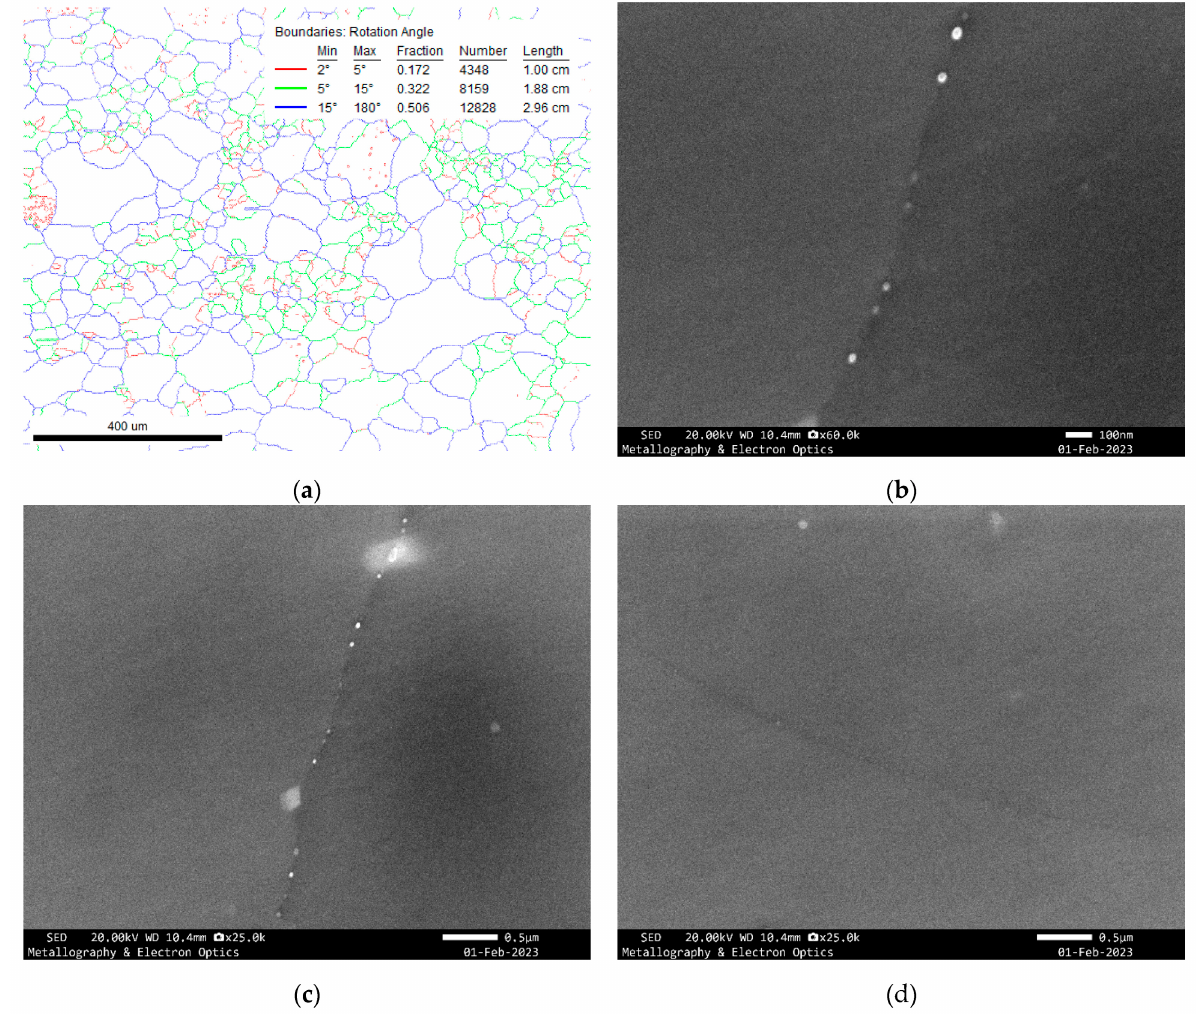
Figure 8. ( a ) EBSD misorientation map of the mid-thickness area of the profile of the SC sample in AOI 4; precipitation behaviors on HA ( b ), LA ( c ), and SB ( d ).